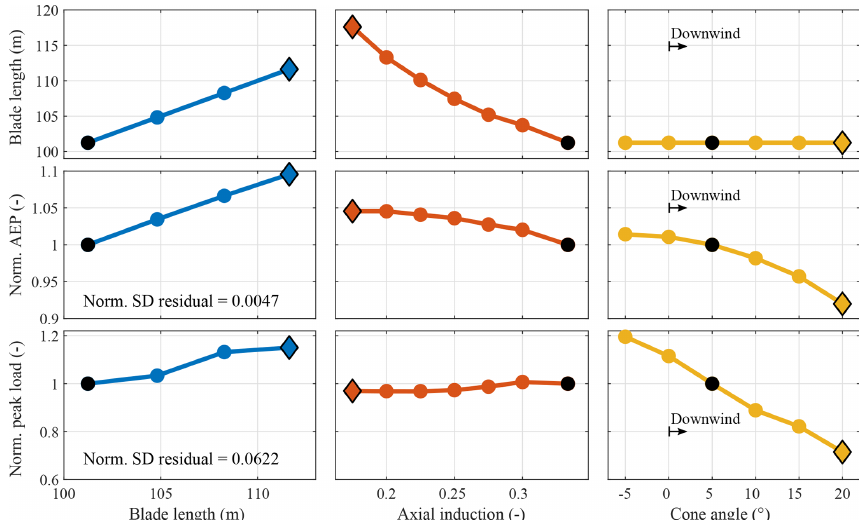
Figure 8. Summary of aerodynamic design studies: the blade length, axial induction (in combination with blade length, chord, and twist), and cone angle are varied, while the AEP and peak blade load are calculated and compared to the base case (SUMR-13A, black dot in all). The standard deviations of the residuals for AEP and peak flapwise load are normalized to the SUMR-13A values and apply across all design studies. All rotors here are two-bladed, and positive cone angles correspond to downwind rotors. Unless otherwise specified, the available rotor power is 13.9MW, the axial induction is 0.333, and the cone angle is 5 ◦ .